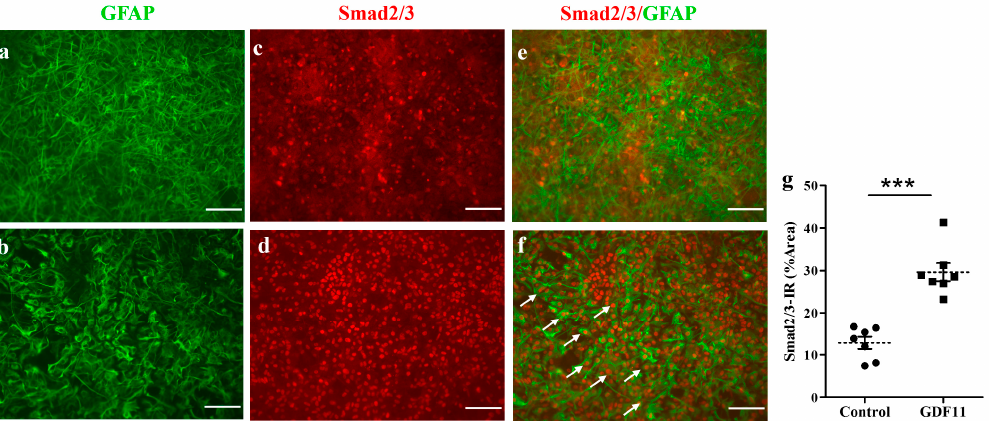
Figure 6. GDF11 induced Smad2/3 translocation in neuron–glial cultures. ( a , c , e ) Control; ( b , d , f ) GDF11 2 h treatment; ( g ) The quantitative results of smad2/3 immunoreactivity (IR) in control and GDF11 cultures treated for 2 h; ( a , b ): GFAP-IR, ( c , d ): Smad2/3-IR, ( e , f ): Double-labeling immunore- activity of GFAP (green) and Smad2/3 (red). The arrows depict nuclear location of Smad2/3 in GFAP-IR astroglia in neuron–glial cultures. The results are reported as mean ± SEM in each group from three independent experiments. *** p < 0.001 indicates a significant difference between the con- trol and GDF11 treatment by unpaired Student t -test. Magnification: 200×. Scale bar: 100 μ